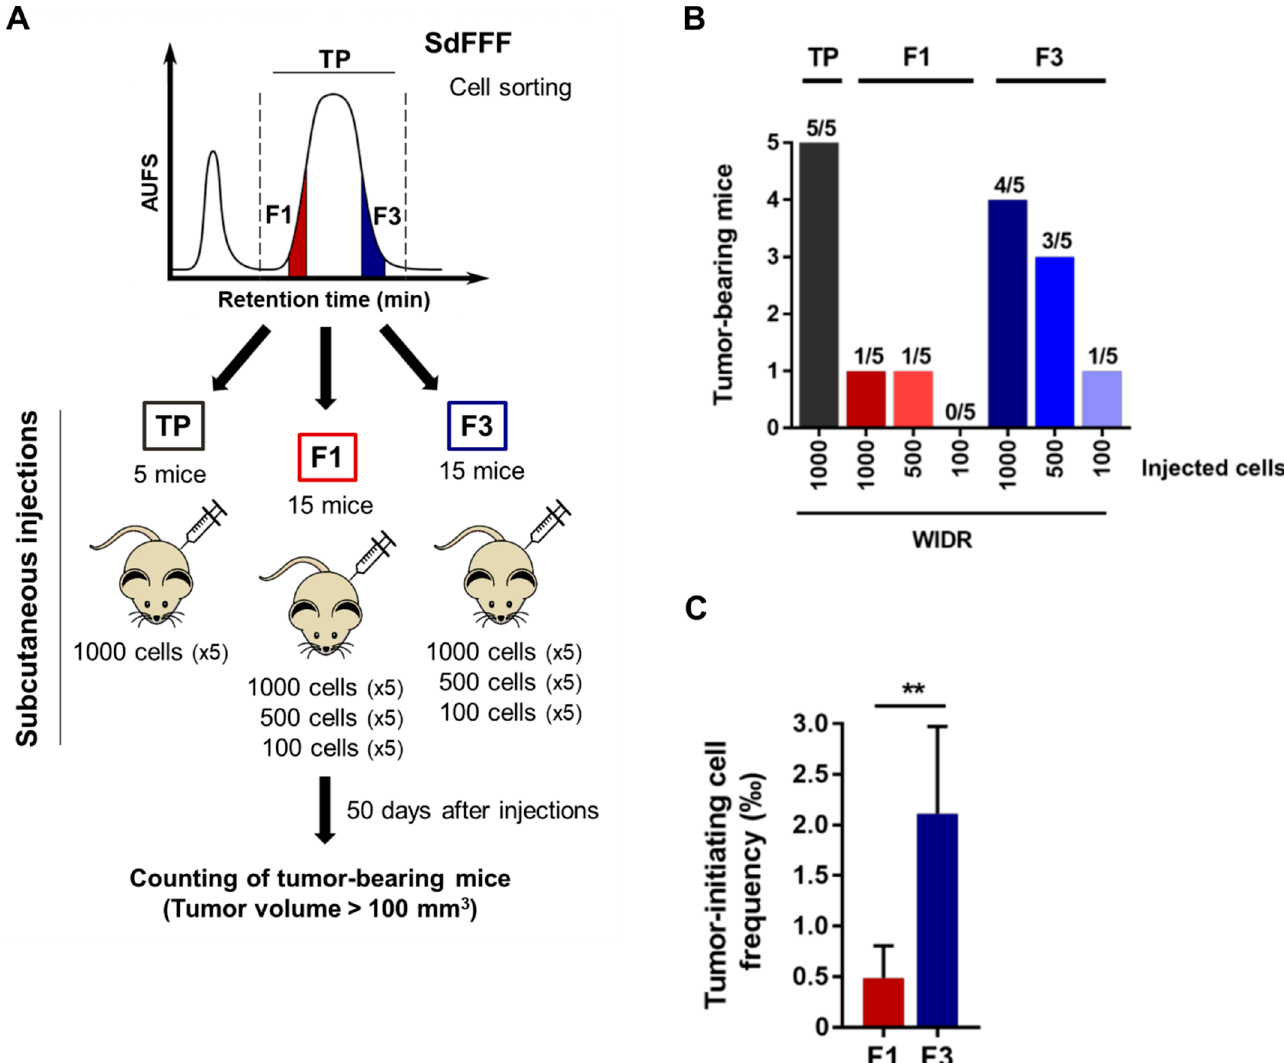
Figure 3. Tumorigenic capacity of the F3 subpopulation in immunodeficient mice, even after an injection of only 100 cells. ( A ) Schematic representation of the in vivo tumor initiation assay. Nude mice were injected subcutaneously with either 1000, 500, or 100 F1 and F3 cells of the WiDr cell line. ( B ) The number of tumor bearing mice (tumor > 100 mm 3 ) was evaluated seven weeks after injection and summarized in the bar plot. ( C ) Tumor initiating cell frequency was determined from in vivo results using extreme limiting dilution analysis (ELDA) software. Results are represented as means ± SEM and statistical differences with ** p value < 0.01 using chi-squared test of ELDA software (https://bioinf.wehi.edu.au/software/elda/, accessed on 28 January